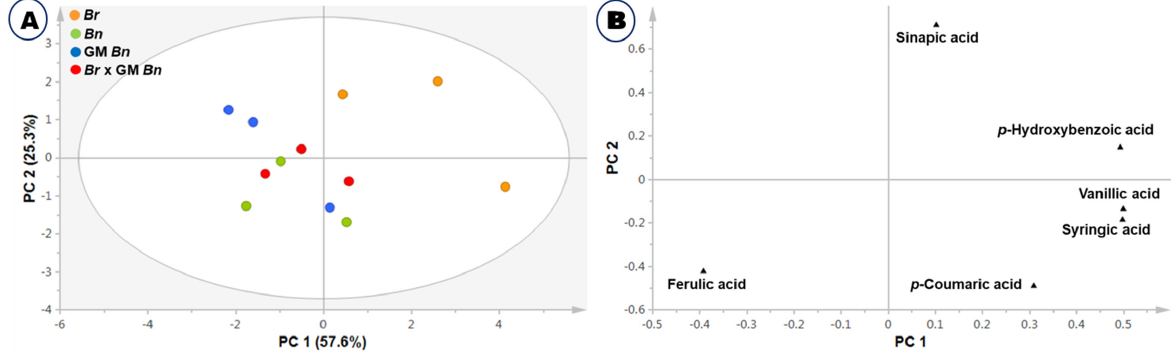
Figure 4. Score ( A ) and loading ( B ) plots of principal components 1 and 2 of the PCA results obtained from data on six total phenolic acids of four varieties.